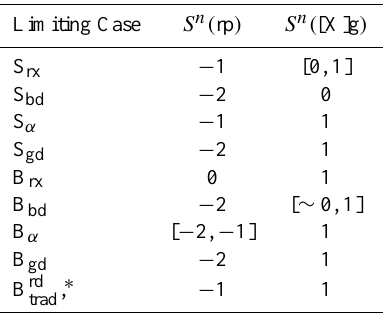
Table 4. Scalability of limiting cases with respect to r p and [X] g expressed by the normalised sensitivity coefficient of each archety- pal case (see Eq. 19). Square brackets indicate the range of possible